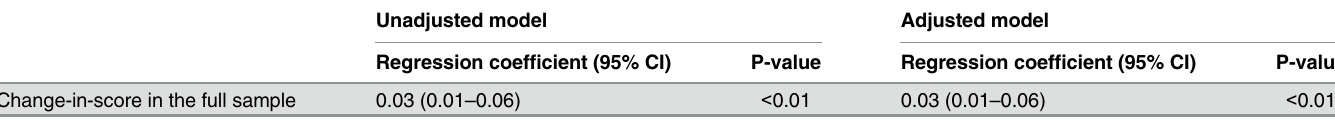
Table 3. Unadjusted and adjusted growth models for annualized change in learning climate (D-RECT)